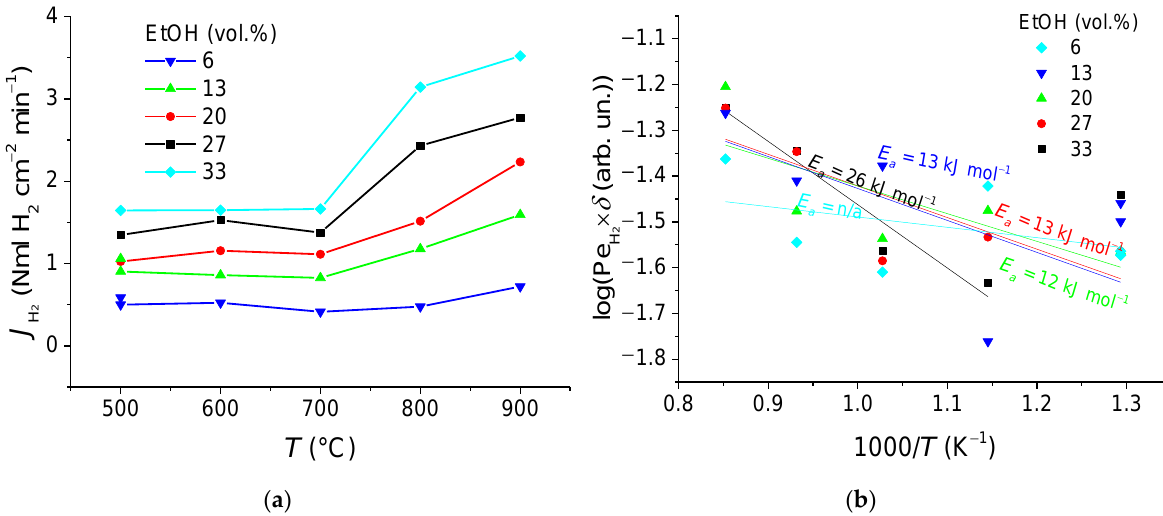
Figure 12. Hydrogen flux dependences on temperature ( a ) and corresponding Arrhenius plots ( b ) for S/E = 2 at the different fuel concentrations.